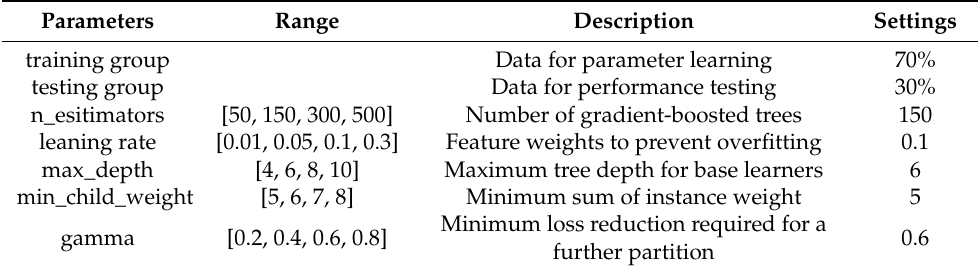
Table 5. Setting of the parameters in the XGBoost